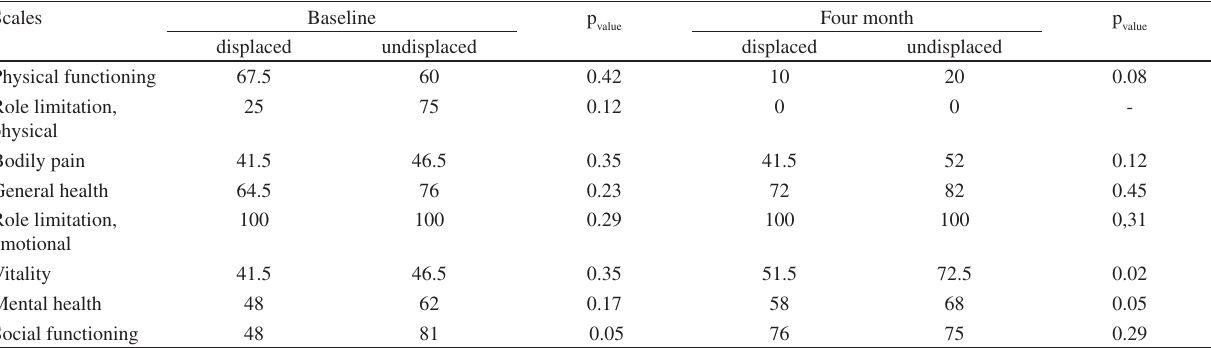
Table 4 - SF-36 scores (median) in patients with undisplaced and displaced FNF at baseline and four month follow-up Scales